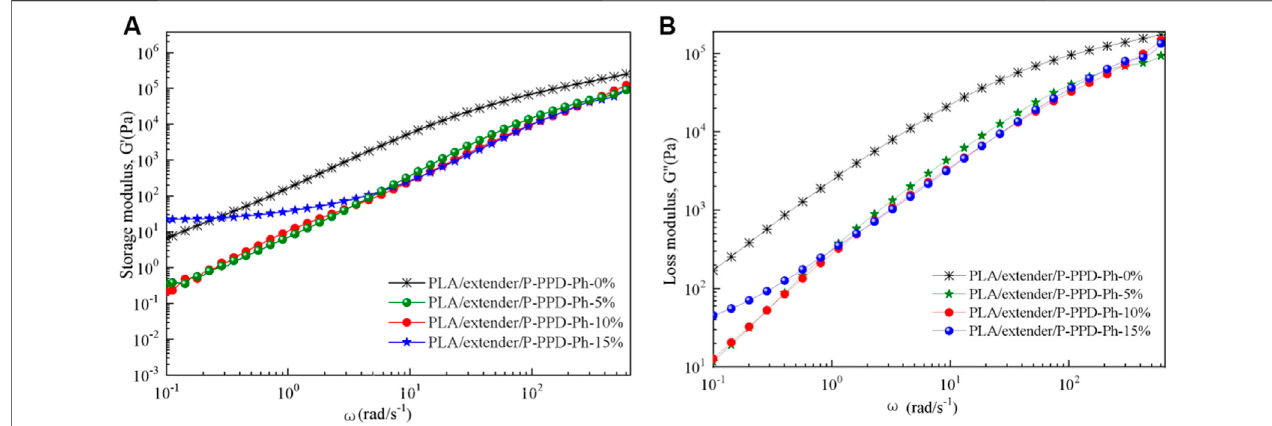
FIGURE 2 | Storage modulus (A) , loss modulus (B) , complex viscosity (C) , and Tan(delta) (D) vs angle frequency for the PLA/P-PPD-Ph-conjugated fl ame- retardant composites at 200 ° C and cone calorimeter test of PLA/P-PPD-Ph-conjugated fl ame-retardant composites; (E) HRR curves, (F) THR curves, (G) CO release curves, (H) and CO 2 release